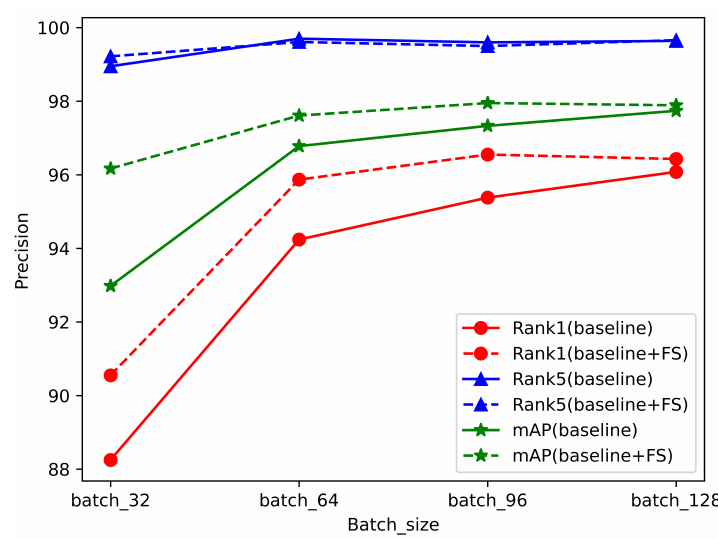
Figure 10. The results of the ablation experiment for FS.